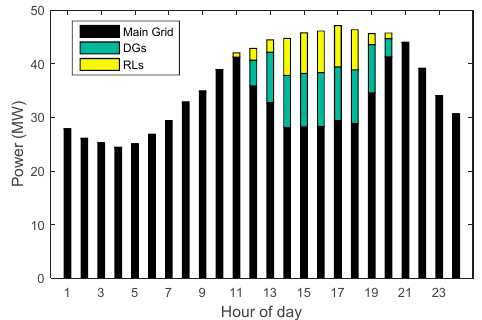
Figure 9. Energy resources scheduling results for Case 5.